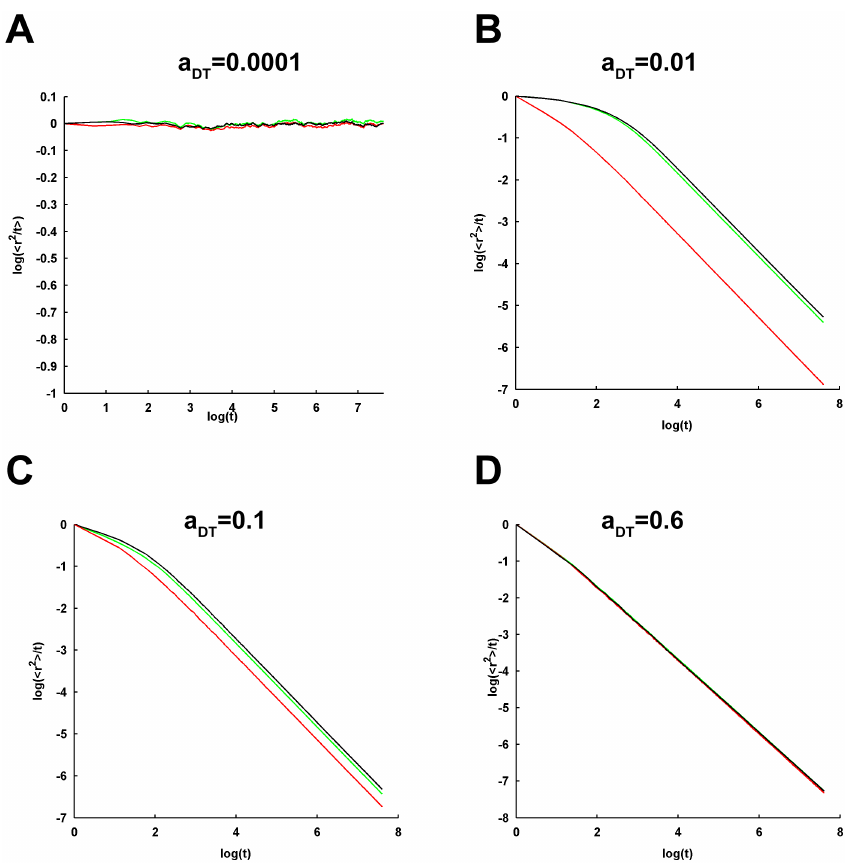
Fig 9. Normalized log-log profiles of the mean-squared displacements of diffusing receptors obtained from the continuous-space and lattice models of diffusion. The convergence of the proposed recursive algorithm for lattice model of self-crowded diffusion to the continuous-space Monte-Carlo simulation of Langevin dynamics is examined under the different self-crowding conditions, shown in (A) a DT = 0.0001, (B) a DT = 0.01, (C) a DT = 0.1 and (D) a DT = 0.6. Moreover, the efficacy of the recursive algorithm over its other possible counterpart neglecting recursion is also checked. The presence of any other reflecting or binding obstacles is not considered. The log-log profiles of the MSD obtained from recursive algorithm (shown in green) closely resemble that obtained from continuous-space diffusion (black) consistently across the different values of a . However, the profiles obtained from non-recursive algorithm DT (red) are observed to converge only for either very low or extremely high a DT . For other intermediate values of a DT , there lies considerable deviations from the outcomes of continuous-space diffusion scheme.